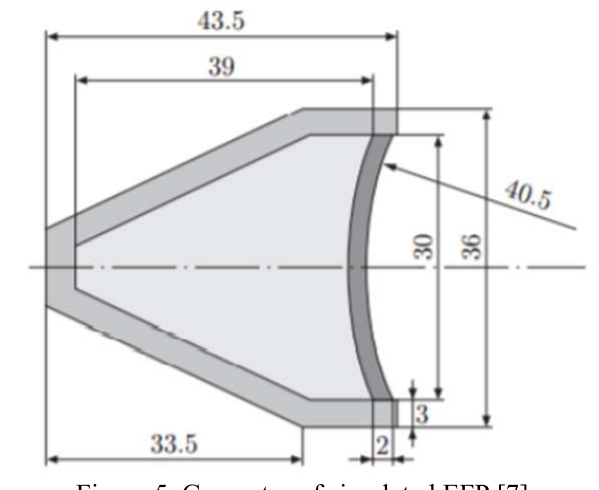
Figure 5. Geometry of simulated EFP